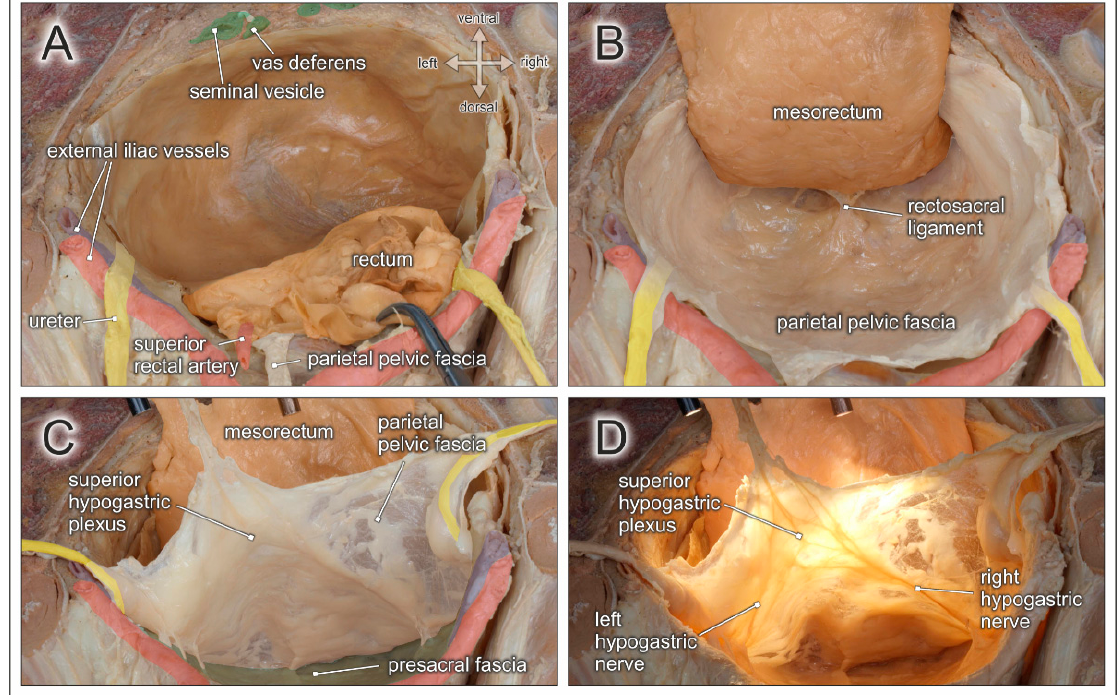
Figure 2. Topographic anatomy of the posterior pelvic compartment. Dorsocranial view of a male pelvis. ( A ) The rectum and the mesorectum with the superior rectal artery are transected at the rectosigmoid junction (clamp). ( B ) Dorsolateral mobilization of the mesorectum in a TME-like manner between the parietal pelvic fascia and the mesorectal fascia along the retrorectal space. Both fasciae are fused by the rectosacral ligament. ( C ) The parietal pelvic fascia and both ureters are lifted to expose the presacral space behind the presacral fascia. ( D ) Diaphanoscopy of the parietal pelvic fascia reveals the embedded superior hypogastric plexus and both hypogastric